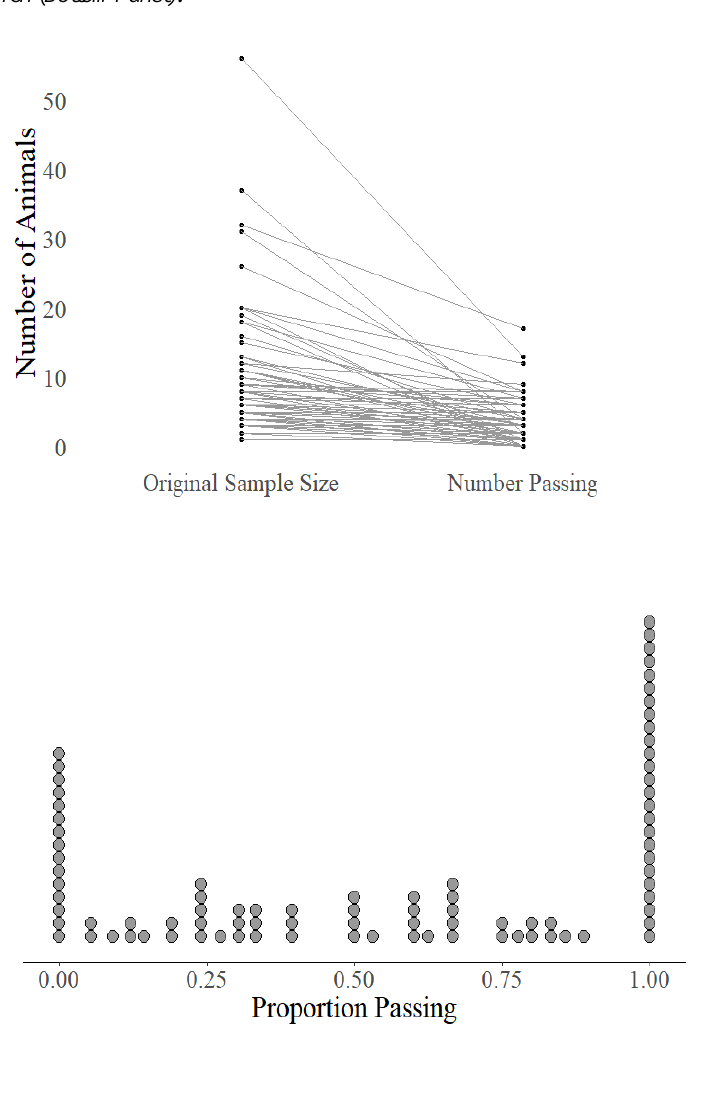
The Number of Animals Passing Each Experimental Test, and the Corresponding Original Sample Size from Our Sample of Physical Cognition Research (Top Panel). The Proportion of Animals Passing the Test in Each Experiment from Our Sample of Physical Cognition Research (Bottom